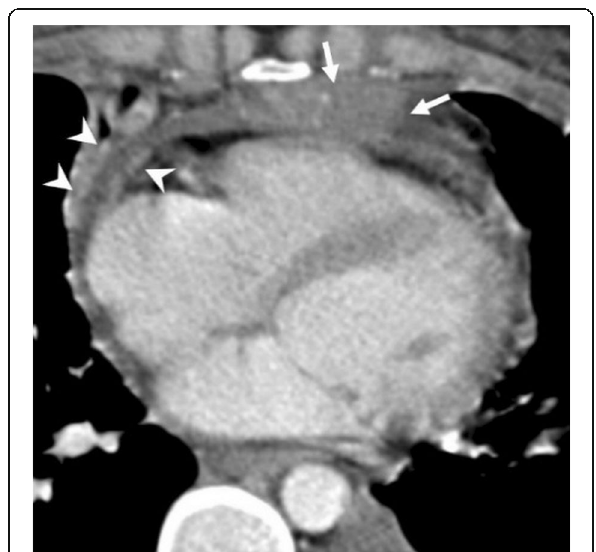
Fig. 16 A 26-year-old woman with pathologically proven mediastinal lymphoma. Axial contrast-enhanced CT image demonstrates the inferior aspect of the mediastinal mass (arrows) and pericardial nodular areas of contrast enhancement and thickening suggestive of pericardial involvement (arrowheads)